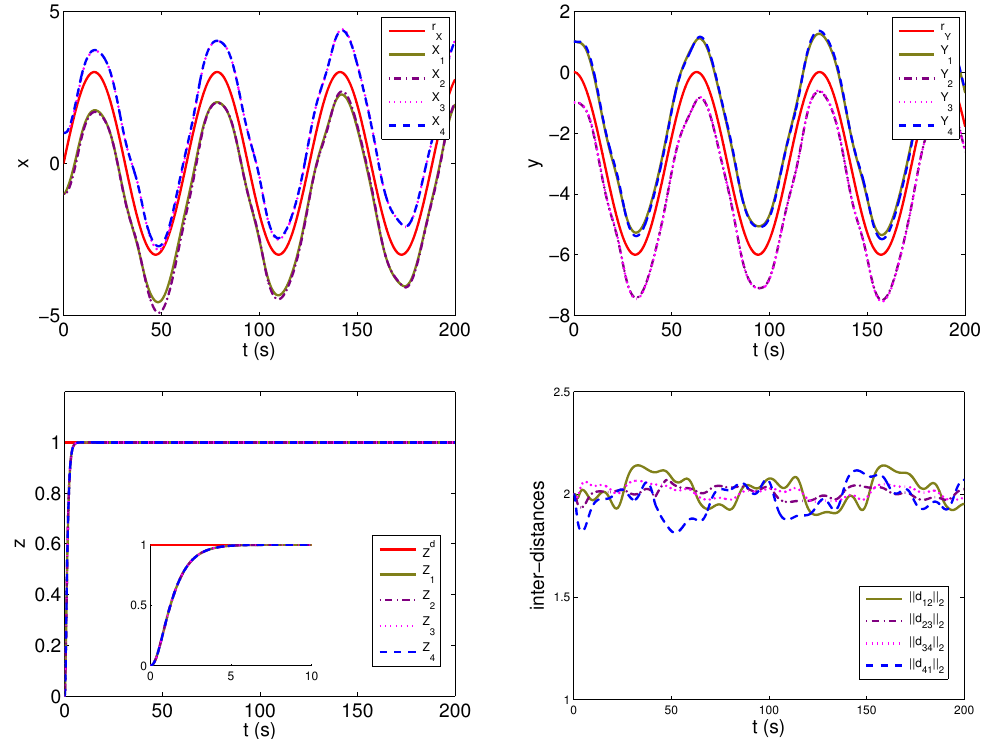
Figure 3. Rigid formation of 4 quadrotors with high-order derivatives estimation, the objective is to track the RFT r ( t ) and meanwhile keep inter-distance between